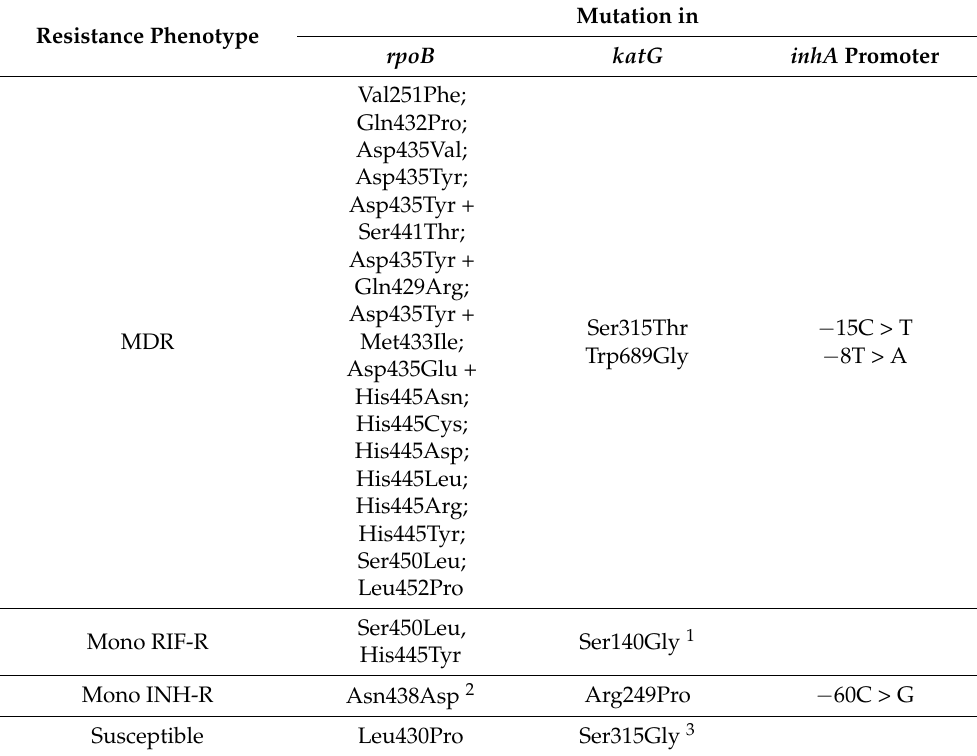
Table 3. Mutations detected in rpoB gene, katG gene, and inhA promoter on clinical specimens and on isolates from our NRC MyRMA collection and tested by MDR/MTB ELITe MGB ® assay, according to resistance